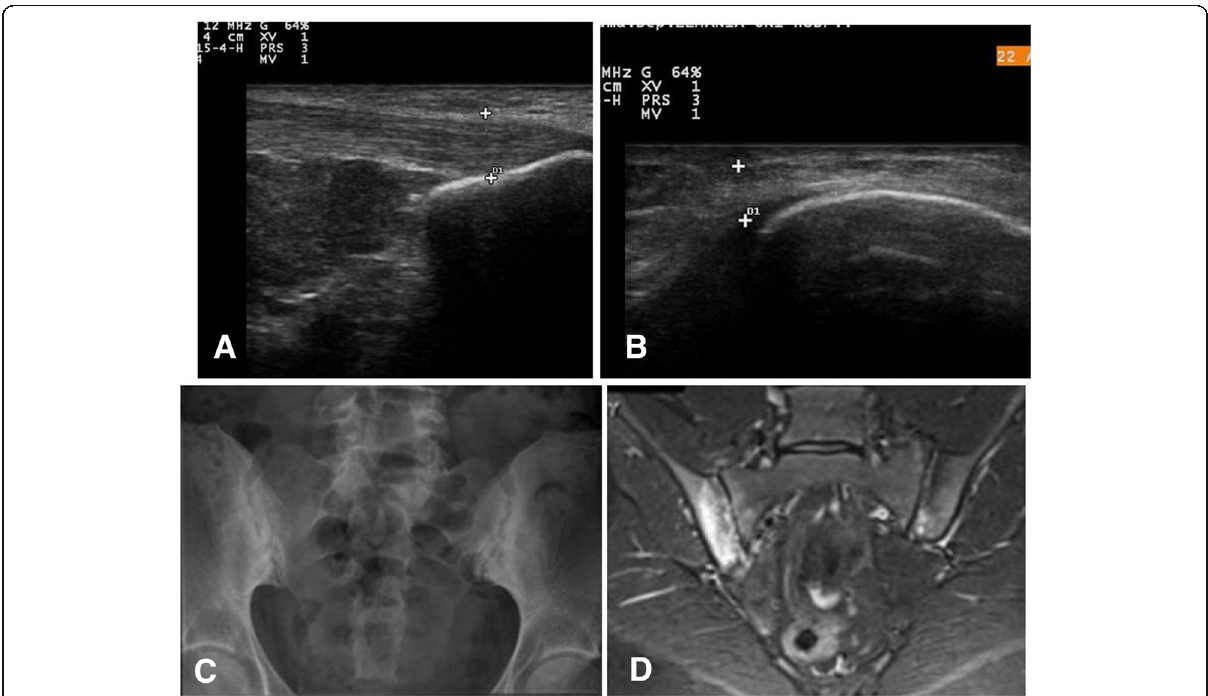
Fig. 2 Female patient 40 years with rheumatoid arthritis. Enthisiitis ( a ) ultrasound of the ankle showed thickened Achilles tendon. b Musculo- skeletal ultrasound of the knee showed quadriceps tendon. c Plain X-ray of the sacroiliac joint AP view showed ankylosis of the sacroiliac joint with sclerotic margin. d T2WI of the sacroiliac joint showed bone edema more evident at the right